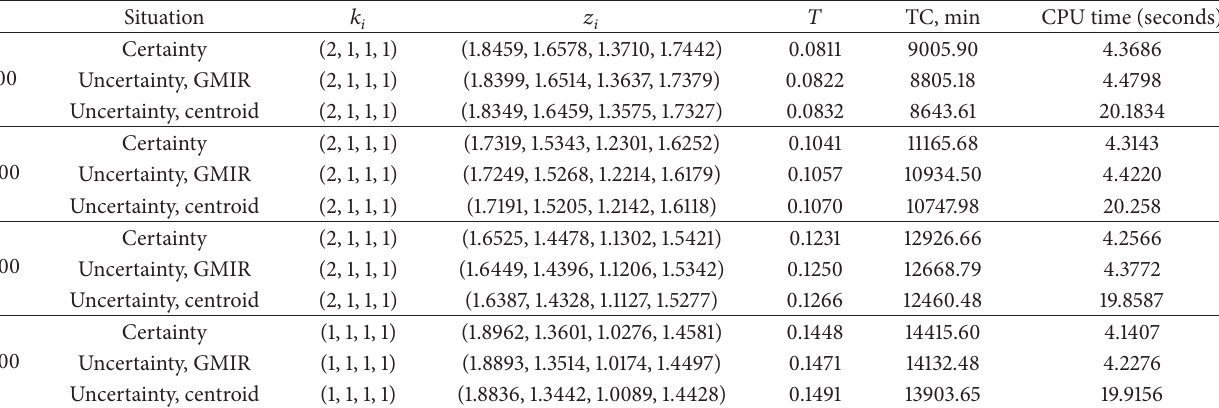
Table 6: Results comparison under different situations (scenarios 1).